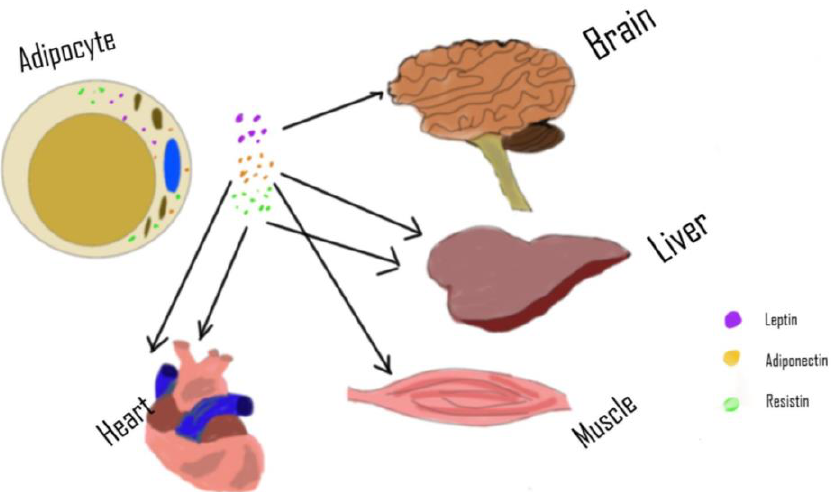
Figure 3. Lipid-filled adipocytes release the hormones adiponectin, leptin, and resistin, which target various tissues to affect their metabolic actions. Adiponectin targets the liver, skeletal muscles, bone, cartilage, heart, and adipose tissues. Leptin primarily targets the brain and central nervous system, while resistin targets adipose tissues, liver endothelium, and heart.